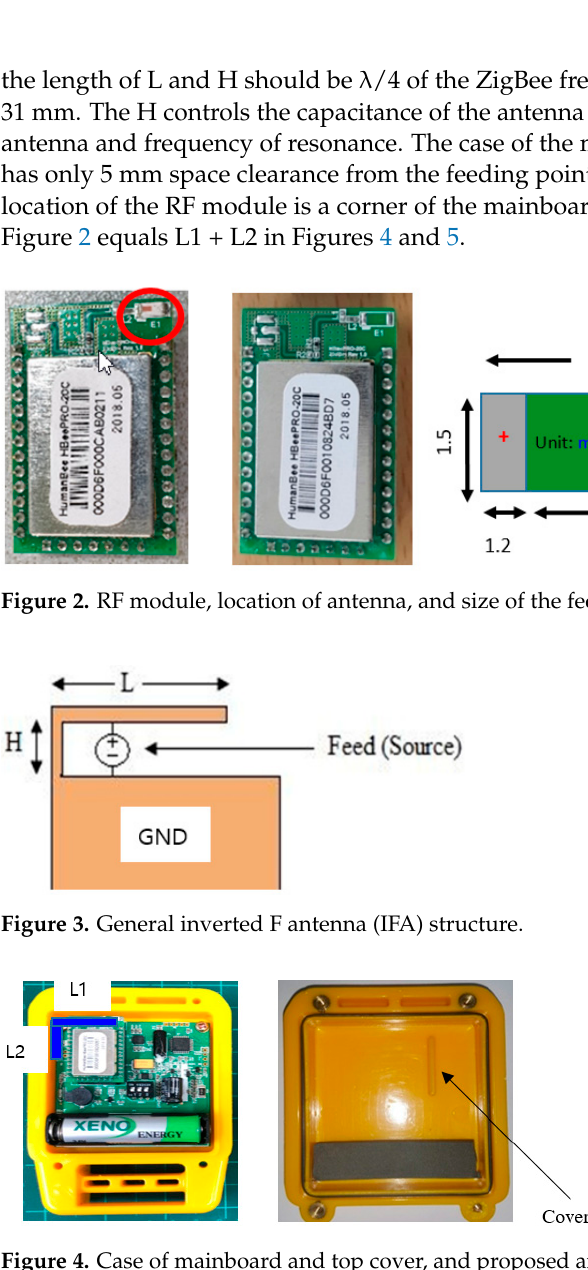
Figure 4. Case of mainboard and top cover, and proposed antenna location in the case with opened-cover view.